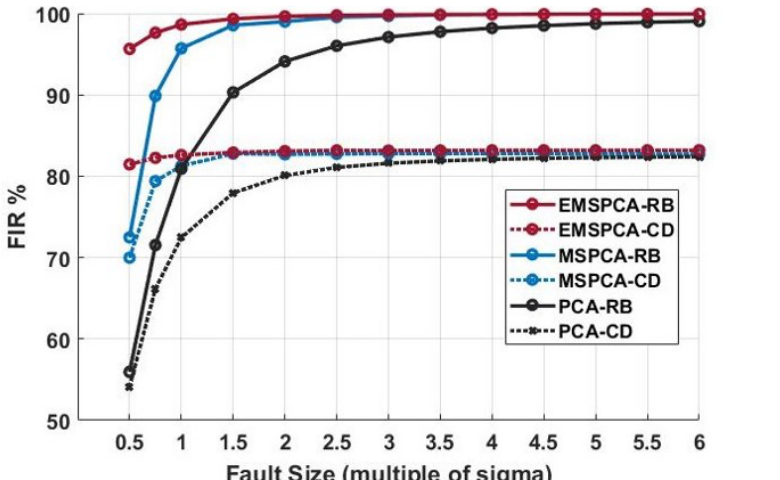
Figure 11. Reconstruction-based (RB) and complete decomposition (CD) fault isolation rate (FIR) for EMSPCA and PCA across varying fault sizes and a fixed multiscale decomposition depth of